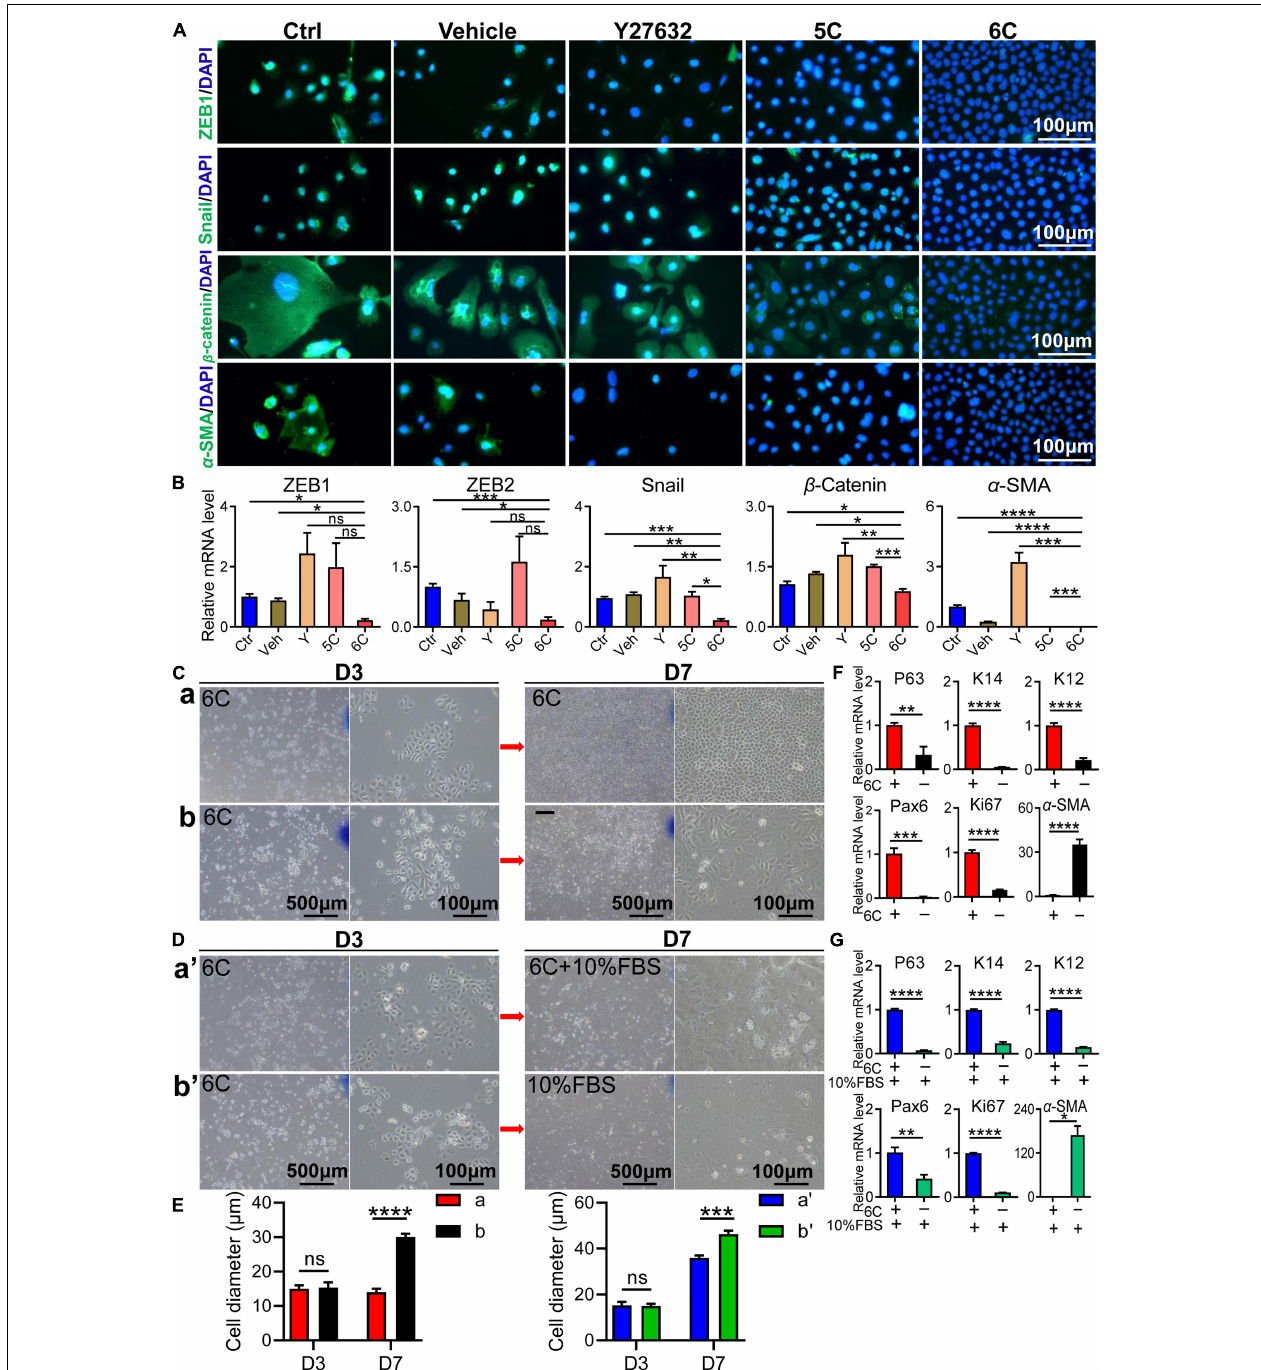
FIGURE 4 | 6C can suppress the occurrence of EMT. (A) Immunofluorescence staining of EMT-related genes after 1 week of cell culture. ZEB1 and Snail are transcription factors of EMT, β -catenin and α -SMA are markers of EMT (green). Nuclei were stained with DAPI (blue). The expression of EMT-related genes in group 6C was significantly reduced. (B) qRT-PCR analysis of ZEB1/2 , Snail, β - catenin and α - SMA gene expression (normalized to ctrl) after 1 week of cell culture. (C) Comparison of cell morphology. a , Treat with 6C for 1 week. b , Treat with 6C for 3 days, then remove 6C and continue to cultivate for 4 days. (D) Comparison of cell morphology. a’ , It was first treated with 6C for 3 days, and then cultured with 6C plus 10% FBS for another 4 days. b’ , Treat with 6C for 3 days, then remove 6C and continue to incubate with 10% FBS for 4 days. (E) Statistical analysis of cell diameter after C and D treatment. (F) After C treatment, qRT-PCR analysis of P63 , K14 , K12 , Pax6 , Ki67 , and α - SMA gene expression (normalized to 6C). (G) After D treatment, qRT-PCR analysis of P63 , K14 , K12 , Pax6 , Ki67 , and α - SMA gene expression (normalized to 6C plus 10% FBS). Data expressed as the means ± SEM from three separate experiments (* P < 0.05, ** P < 0.01, *** P < 0.001, **** P < 0.0001, ns: no